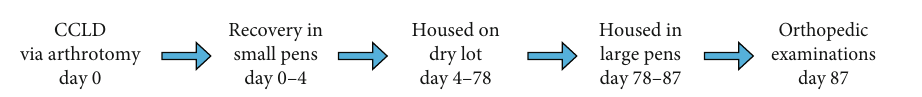
Figure 1: Timeline from CCLD to the diagnosis of PT injury. After postoperative recovery for fi ve days, sheep were given unrestricted mobility in a dry lot for 74 days and received comprehensive orthopedic exams at day 87 after CCLD.